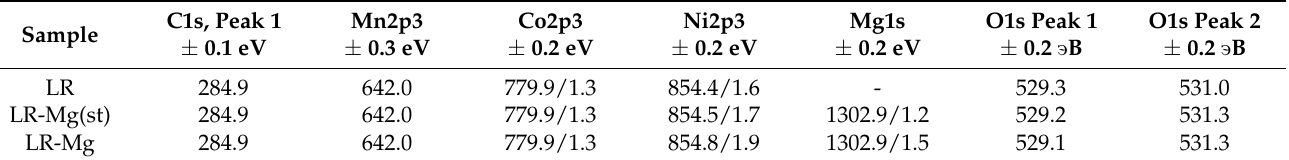
Table 2. Binding energies/FWHM of XP lines in the spectra of LR, LR-Mg, and LR-Mg(st)